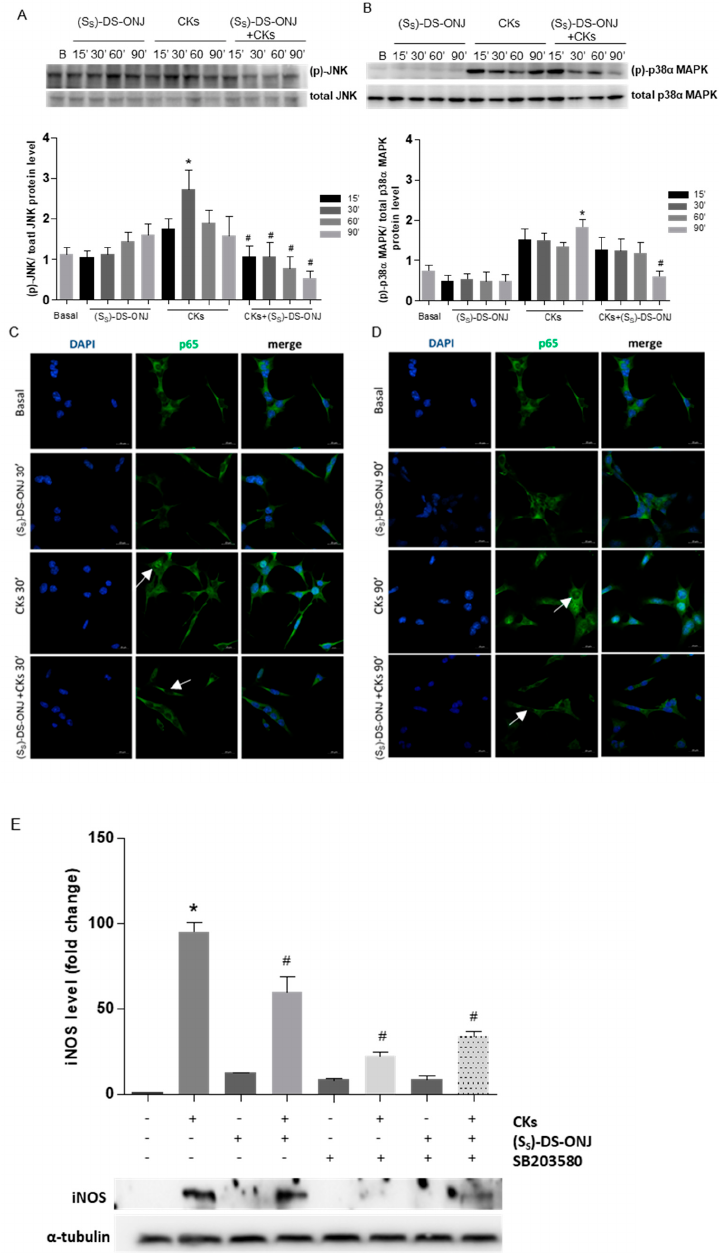
Figure 3. Effects of (S S )-DS-ONJ on stress kinase pathways in CKs-stimulated MCT cells. ( A , B ) Protein extracts were separated by SDS-PAGE and analyzed by Western blot with antibodies against phosphorylated (p)-JNK, total JNK, phosphorylated (p)-p38 α MAPK and total p38 α MAPK. Representative images are shown (n = 6 independent experiments). ( C , D ) Confocal immunofluorescence assessment of the nuclear translocation of p65-NF κ B in MCT cells following stimulation with CKs in the absence or presence of ( S S )-DS-ONJ. The activation of p65-NF κ B nuclear translocation was defined as an increase in the immunofluorescence of p65-NF κ B (green channel) in the nuclear regions. The nuclear regions of MCT cells were visualized by counterstaining of nuclear DNA with DAPI (blue channel). The nuclear localization of p65-NF κ B was detected in MCT cells upon stimulation with CKs at 30 min and 90 min, but not in MCT cells pre-treated with 10 µ M ( S S )-DS-ONJ (white arrows). ( E ) Protein extracts were separated by SDS-PAGE and analyzed by Western blot with antibodies against iNOS and α -tubulin as a loading control. The fold change relative to the basal condition is shown; * p ≤ 0.05 vs. Basal condition; # p ≤ 0.05 vs. CKs stimuli (two-way ANOVA followed by Bonferroni t